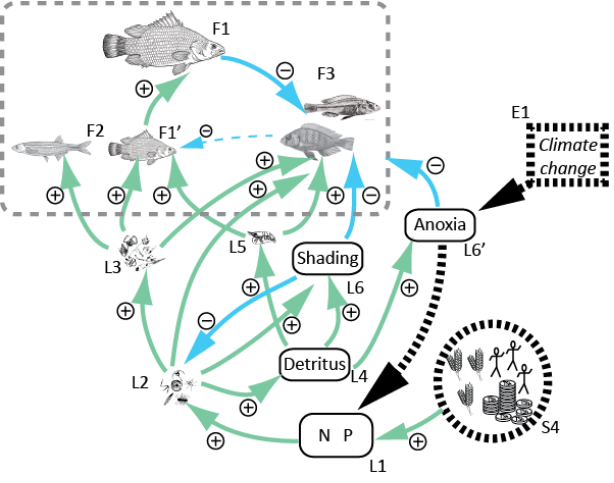
Fig. 1 . Ecological interactions. Green arrows represent growth processes (also identified by + sign); blue arrows represent mortality processes (associated with - signs); thick dotted lines and arrows represent complex systems/interactions not further developed. E refers to environmental variables, F to fish variables, L to limnological variables, and S to societal variables. E1 = climate change; F1 = large Nile perch; F1' = small Nile perch; F2 = Rastrineobola argentea ; F3 = haplochromines; L1 = nitrogen and phosphorus; L2 = phytoplankton; L3 = zooplankton; L4 = detritus; L5 = Caridina nilotica ; L6 = shading; L6' = anoxia; S4 = local and regional economy and